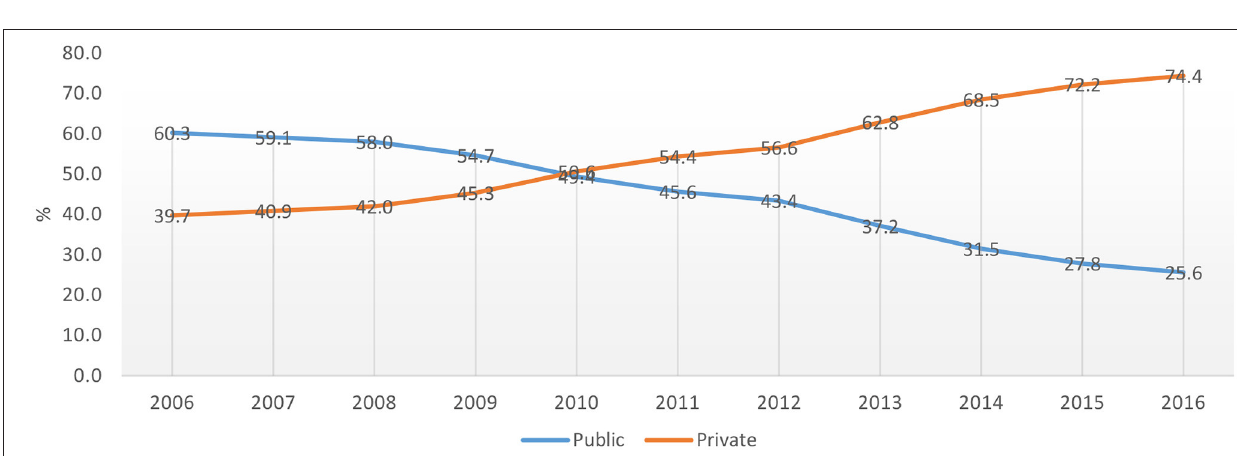
FIGURE 4 | The distribution of Turkey’s installed capacity by the public and private sectors (2005–2015) Source: TEIA ¸S (Turkey Electricity Transmission Company) 14